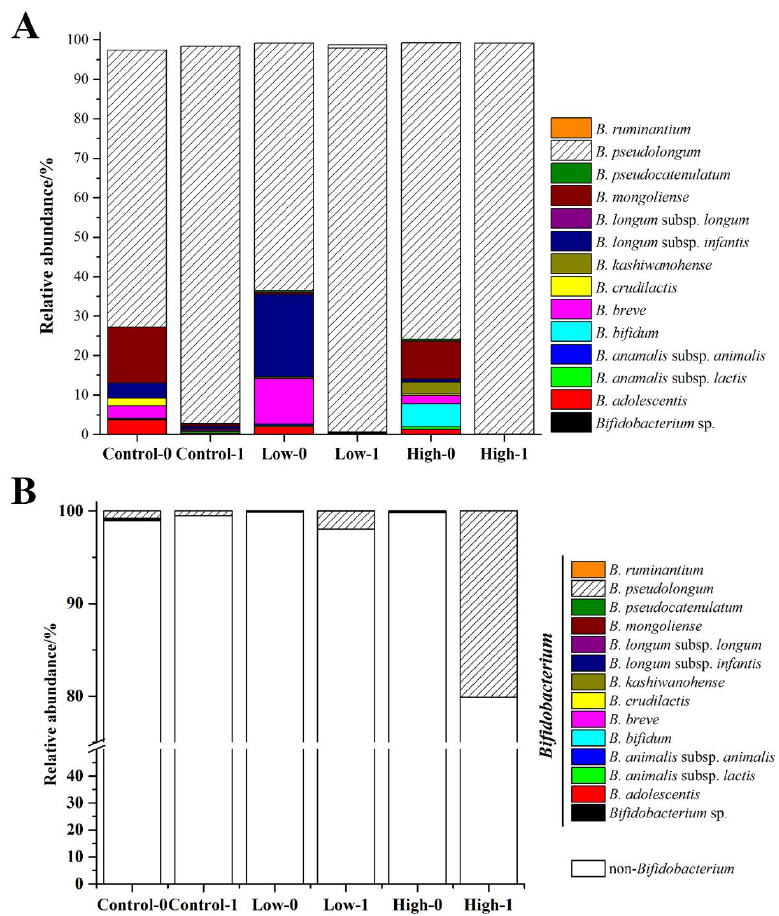
Figure 5. Effects of different doses of FOS on the relative abundance of Bifidobacterium species in the Bifidobacterium genus ( A ) and in the fecal microbiota ( B ) . “0” stands for before FOS intervention and “1” stands for after FOS intervention.